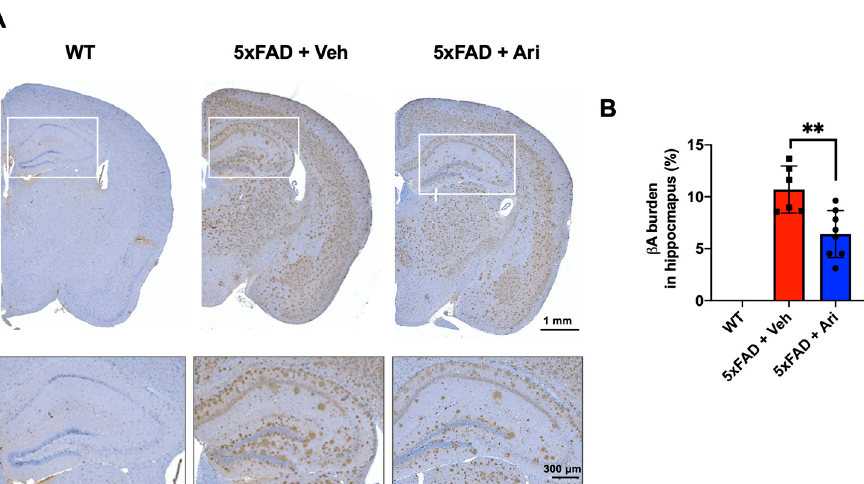
Figure 2. Aripiprazole administration decreased β -amyloid deposition in the hippocampus of 5xFAD mice. ( A ) Representative immunohistochemistry images of β A deposits (in brown) in the brain of 5xFAD mice treated with aripiprazole. Squares show higher magnification of hippocampus regions. ( B ) Quantification of β A burden in the hippocampus of WT ( n = 5), 5xFAD + Veh ( n = 6), and 5xFAD + Ari ( n = 7) group. 5xFAD + Ari and 5xFAD + Veh groups showed statistically significant